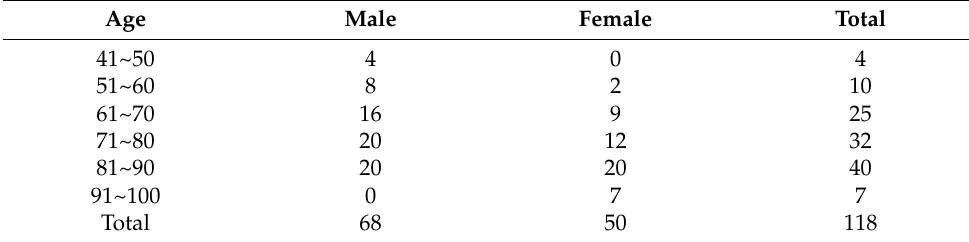
Table 1. Gender and age distribution of Korean cadavers. ( n =